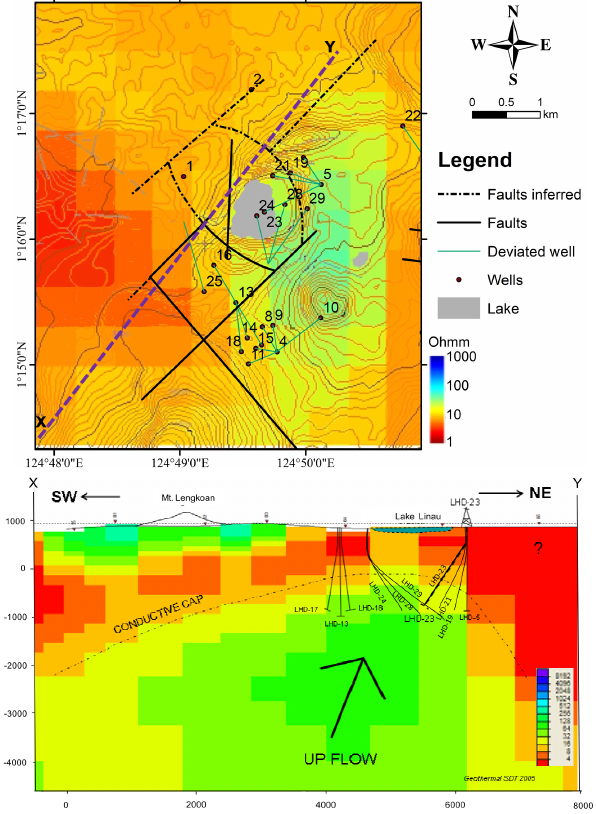
Figure 4. Magnetotellurics (MT) survey data in the field area [7].